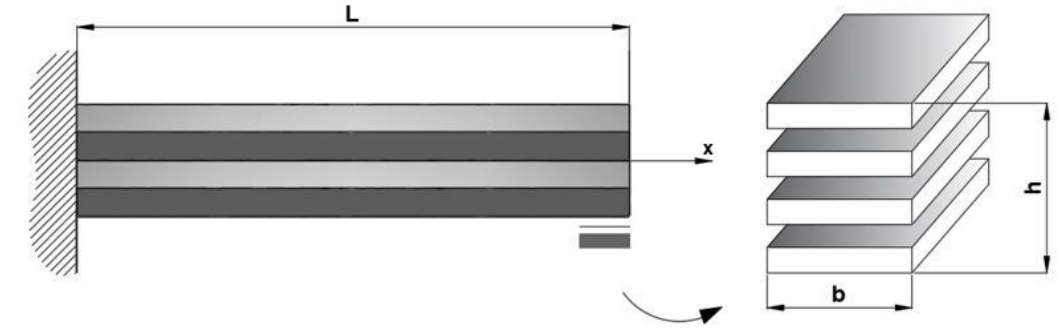
Figure 9. Clamped-Supported (CS) laminated composite beam problem model.